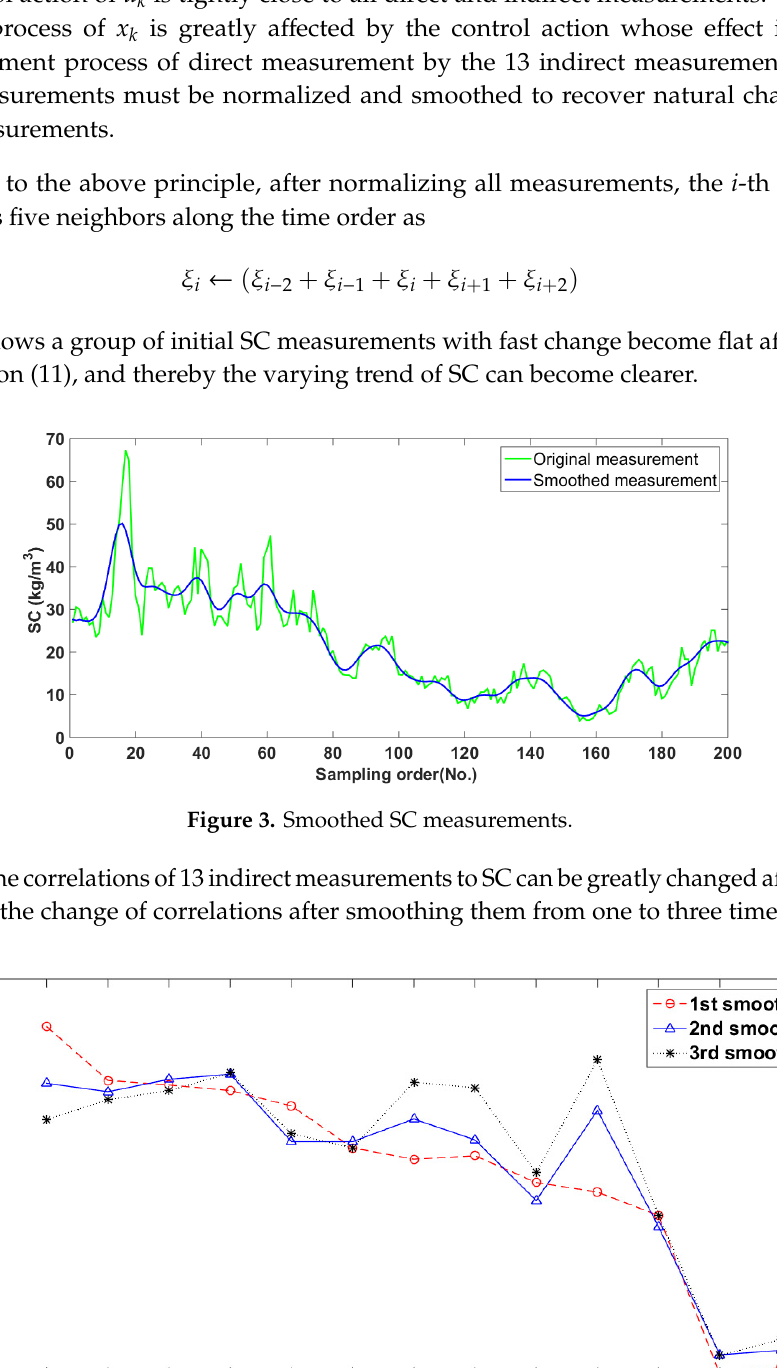
Figure 4. Changed correlation after smoothing measurements.